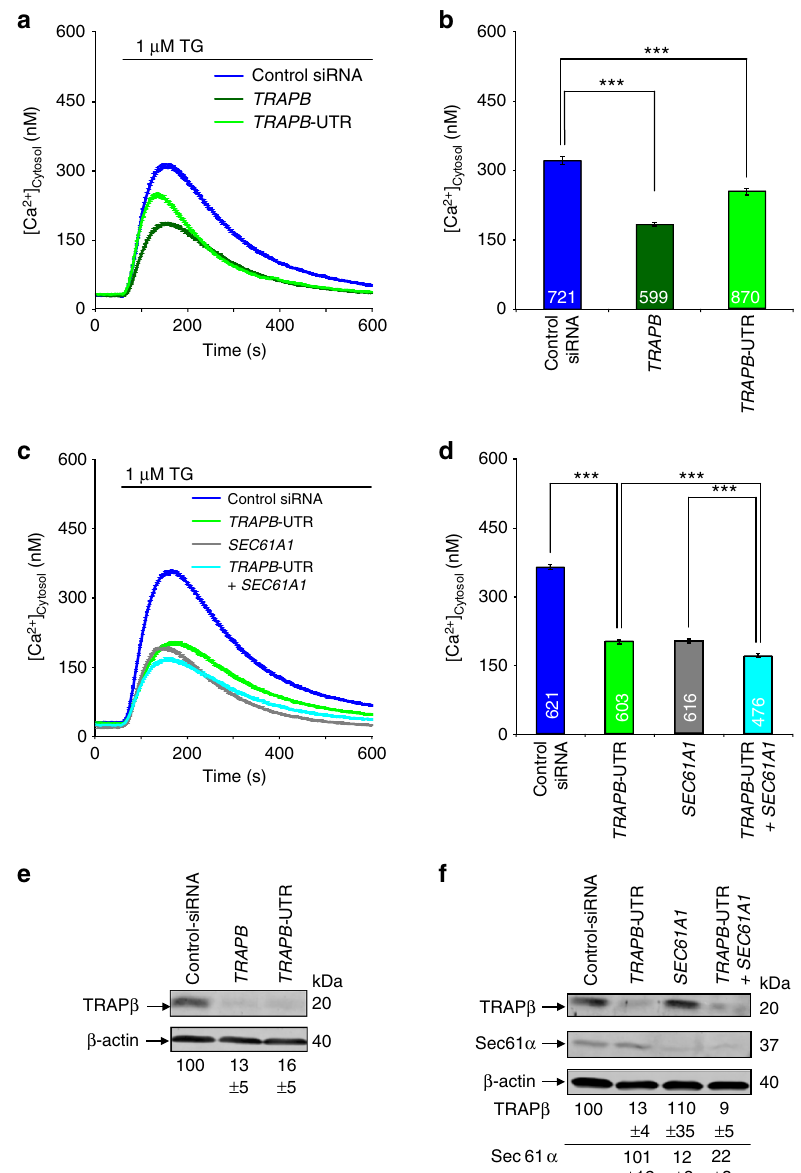
Fig. 7 TRAP depletion plus live-cell Ca 2 + imaging reveals a TRAP function in Sec61-channel opening. HeLa cells were treated with the indicated siRNAs for 96 h, loaded with Fura 2, and subjected to live-cell imaging of cytosolic Ca 2 + following our established procedure. Ca 2 + release was unmasked by the addition of thapsigargin (TG) in the presence of external EGTA. a , c Average values are presented. Error bars represent standard error of the mean (s.e.m.). b , d Statistical analysis of the changes in cytosolic Ca 2 + after TG addition in a , c . Error bars represent s.e.m. P -values of <0.001 by unpaired t -test were de fi ned as signi fi cant, and are indicated by three asterisks (***). The numbers of analyzed cells are indicated. Data were collected in at least three independent experiments, with triplicate cultures for each condition. Knock-down ef fi ciency was evaluated by western blots. e , f A representative western blot is shown, along with the silencing statistics (mean values with fi broblasts versus control fi broblasts using the same analysis negatively affected by transient TRAP complex depletion in HeLa work fl ow as in Fig. 1d, f. Fifteen of these 279 proteins had also cells, i.e. none for membrane proteins and only four proteins with been negatively affected by TRAP depletion in HeLa cells. Pro- SP (not counting TRAP subunits) (Supplementary Fig. 2b). teomic analysis con fi rmed the almost complete absence of TRAP Strikingly, 30 of the negatively affected SP proteins are N-glyco- complex, as seen as absence of TRAPß, in fi broblasts from CDG proteins, 15 have SP with a GP content of >15% (Supplementary patients with mutations in the TRAPG or TRAPD genes 27 (Sup- Fig. 7b-d, Supplementary Table 1). In the case of membrane plementary Tables 1, 2). Furthermore, this analysis con fi rmed the proteins with TMH, 17 are N-glycoproteins, 9 have TMH with absence of the OST subunit TUSC3 (Supplementary Table 1). GP content of >15% (Supplementary Fig. 7b, e-f, Supplementary 36% of the negatively affected proteins, i.e. 100 proteins were Table 2). Thus, the results from these chronically TRAP-depleted assigned to the secretory pathway, including 41 membrane pro- cells partially con fi rmed that the GP content of SP plays an teins and 34 proteins with SP (Supplementary Fig. 7a, b). There important role for TRAP dependence of precursor polypeptides was hardly any overlap between these proteins and the proteins in ER protein import. However, the results from the TRAP